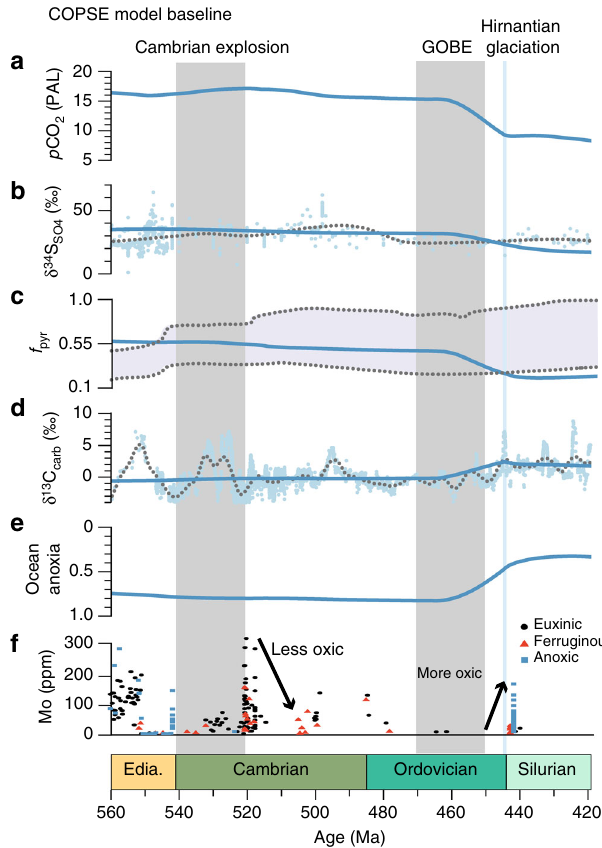
Fig. 3 COPSE baseline model simulation. Simulation as presented in ref. 27 . a Atmospheric CO 2 . b Average δ 34 S SO4 of seawater. c Pyrite fraction of sulphur burial. d Average δ 13 C carb of seawater. e Degree of ocean anoxia (1 = completely anoxic, 0 = completely oxic). f Summary of the evolution of sedimentary Mo concentrations over time. Model outcomes (in blue) are compared to δ 13 C carb and δ 13 S SO4 data and the sedimentary Mo concentrations, which is re fl ective of the extent of ocean oxygenation and is supported by multiple independent proxies (see Supplementary Note 1). Dotted lines in panels b and d represents a local regression (LOESS) fi t to the data. Grey shaded areas indicate the Cambrian explosion (540 – 521 Ma) and the Great Ordovician Biodiversi fi cation Event (GOBE; 470 – 450 Ma). Blue shaded line indicates the Hirnantian